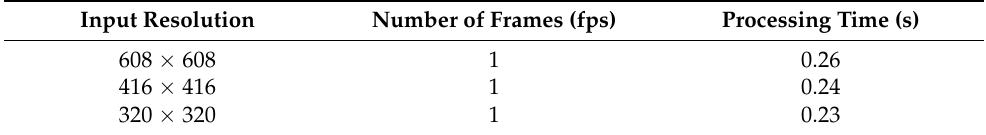
Table 9. Average frame processing time (in seconds) per sequence for various image